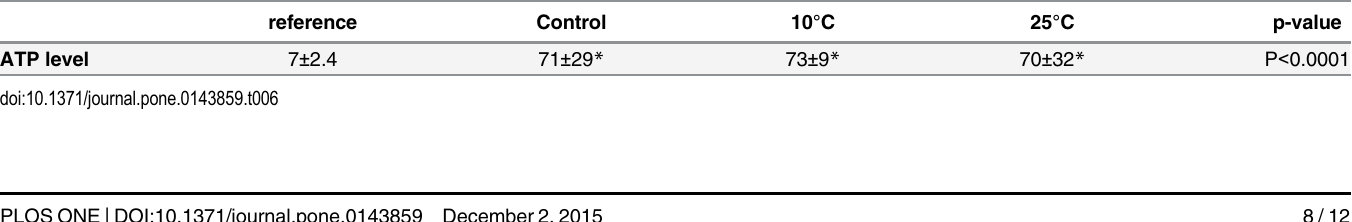
Table 6. Renal ATP content after SCS in the reference, control and the gradual rewarming groups after 90 minutes perfusion in the frozen tissue samples. * P < 0.05 vs Reference group. Values are mean ± standard